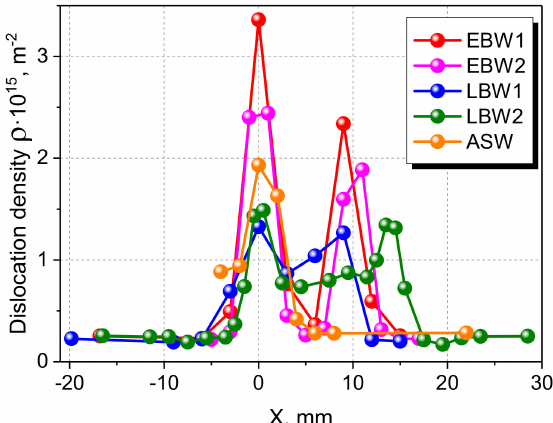
Figure 10. Dislocation density distributions vs. scan coordinate X for all investigated Charpy specimens. The weld seams centers are located at X = 0 mm and X = 9 mm (X = 14 mm for